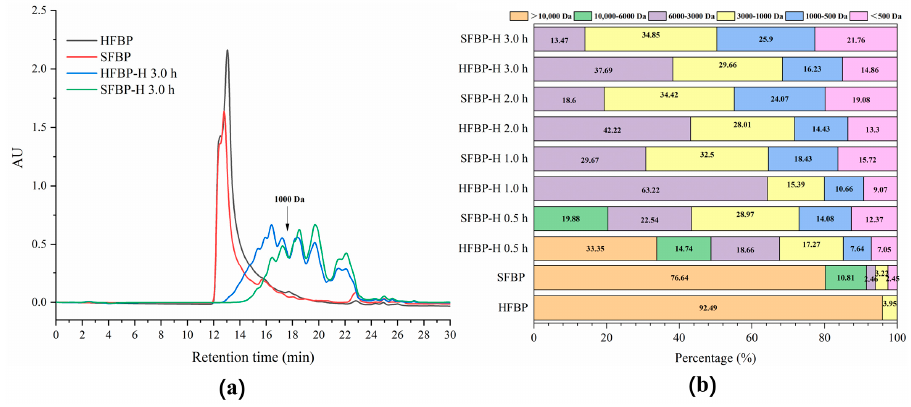
Figure 3. Distribution of molecular weights of SFBP-H and HFBP-H. ( a ) The molecular weight distribution of bone protein and bone hydrolysates. ( b ) Fractions of the chromatogram based on molecular weights of SFBP-H and HFBP-H. SFBP: fish bone protein prepared through steam explosion-assisted extraction; HFBP: fish bone protein prepared through hot-pressure extraction; SFBP-H: SFBP hydrolysates; HFBP-H: HFBP hydrolysates.